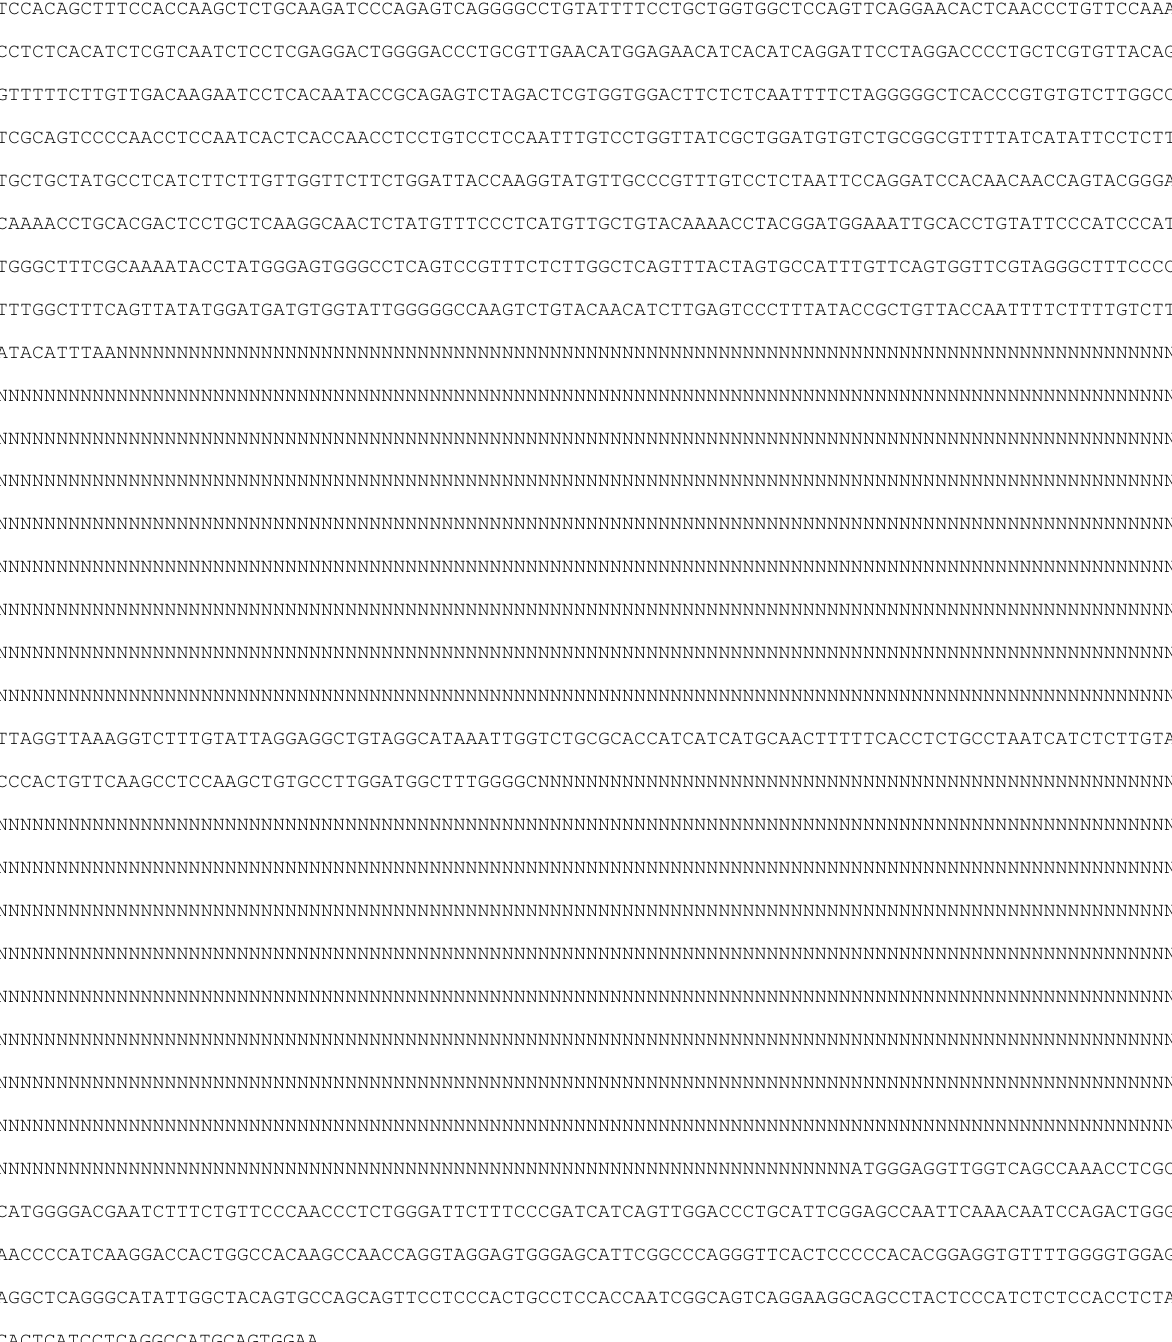
Figure 10. Example output of the “PadSeq” tool. The two input fragments have been placed at the specified location within a backbone